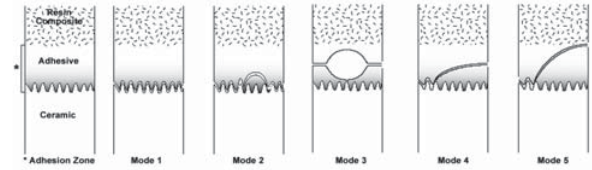
FIGURE 6- Schematic representation (side view) of the modes of failure for the microtensile bond strength test of ceramic bonded to resin composite, based on crack initiation and principles of fractography. Mode 1: adhesive separation at the ceramic-adhesive resin interface. Mode 2: failure starts at the ceramic-adhesive interface, goes into the adhesive resin and returns to the interface. Mode 3: failure from internal flaw (penny-shape internal crack). Mode 4: failure starts at the ceramic-adhesive interface propagates through the adhesive resin. Mode 5: failure starts at the ceramic-adhesive interface, goes through the adhesive resin to reach the resin composite- adhesive interface. From Della Bona, et al. 27 ,